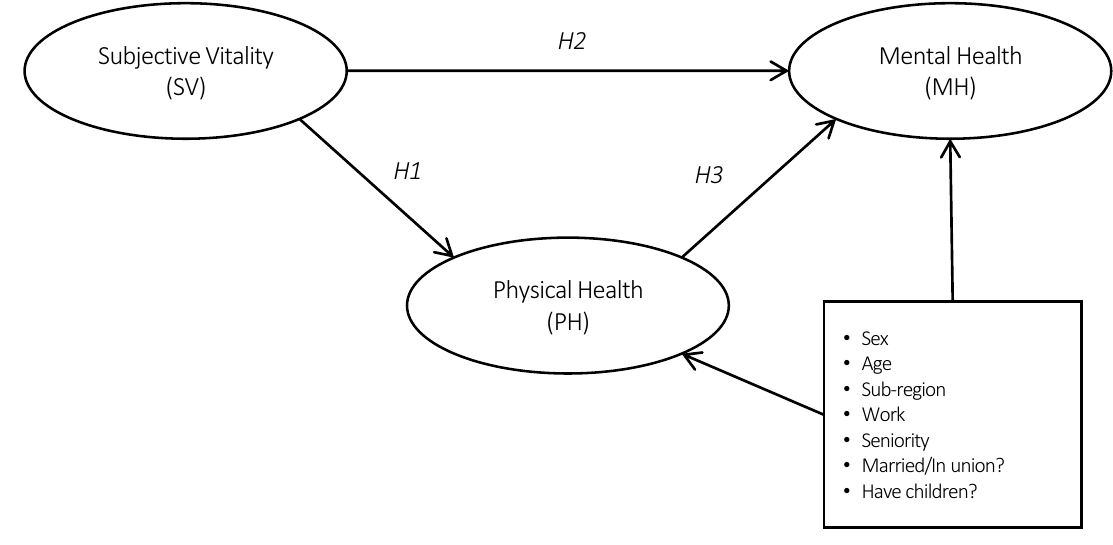
Figure 1. Conceptual